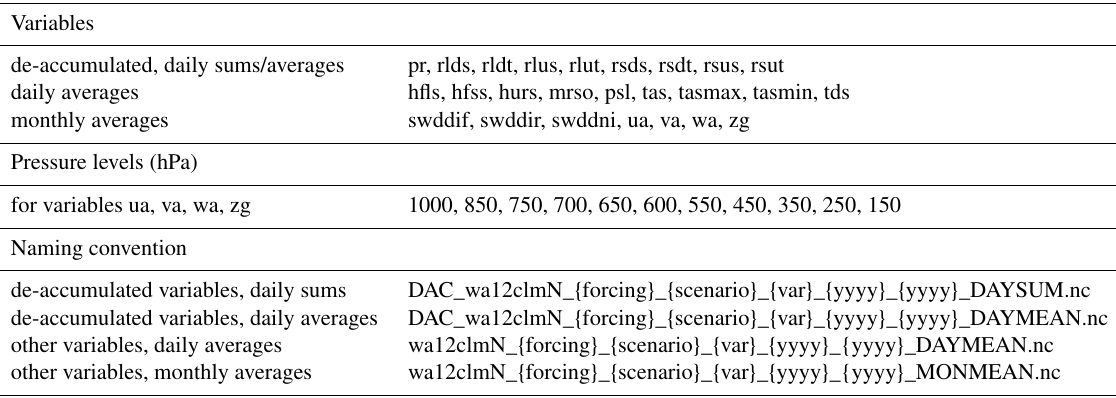
Table A6. Subset of data available at PANGAEA. The variables and de-accumulation steps are described in Sects. A1 and A6, with the parameters enclosed in curly brackets in Sect.